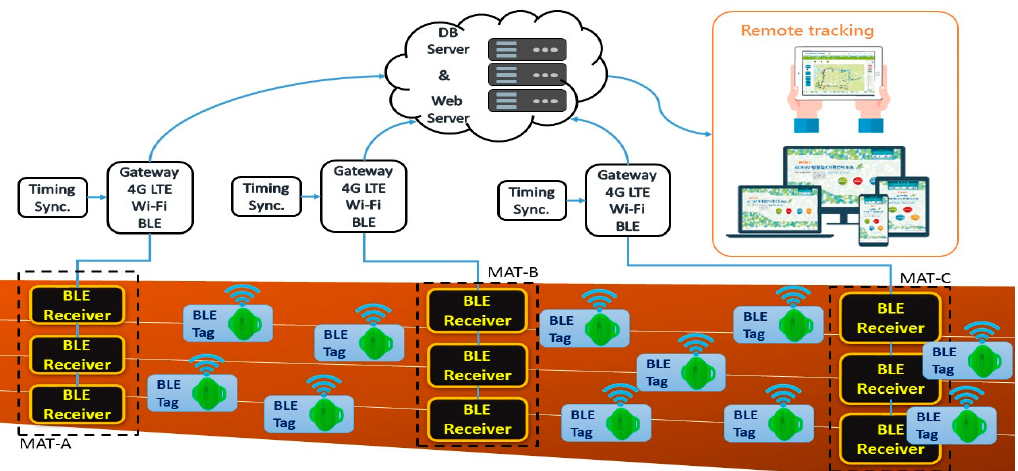
Figure 1. The application structure. DB, database; BLE, Bluetooth Low-Energy; MAT, There are several BLE Receivers connected in series as a longer mat.